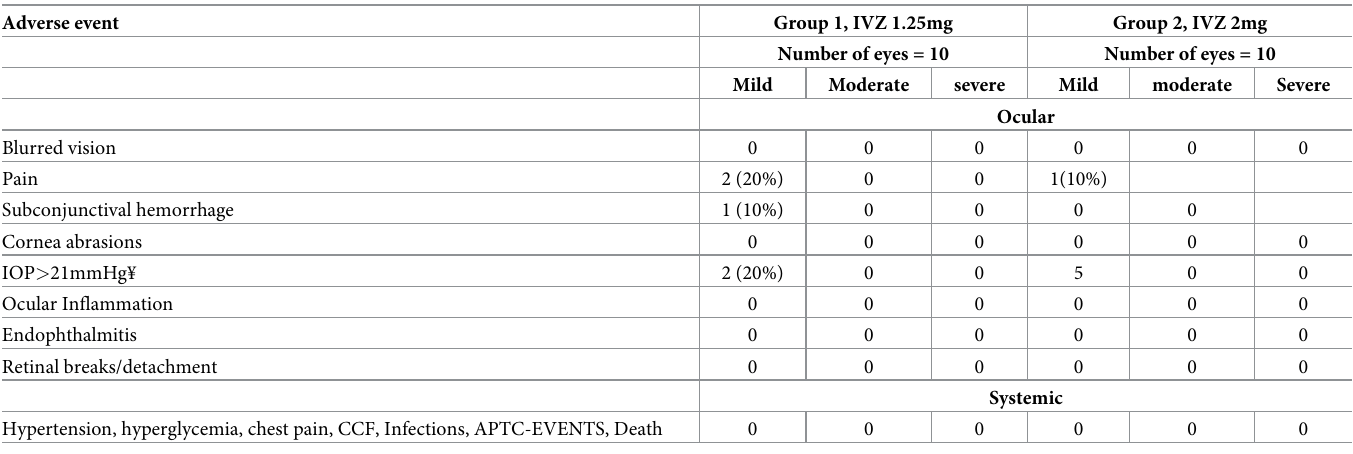
Table 2. Ocular and systemic adverse events by treatment group.